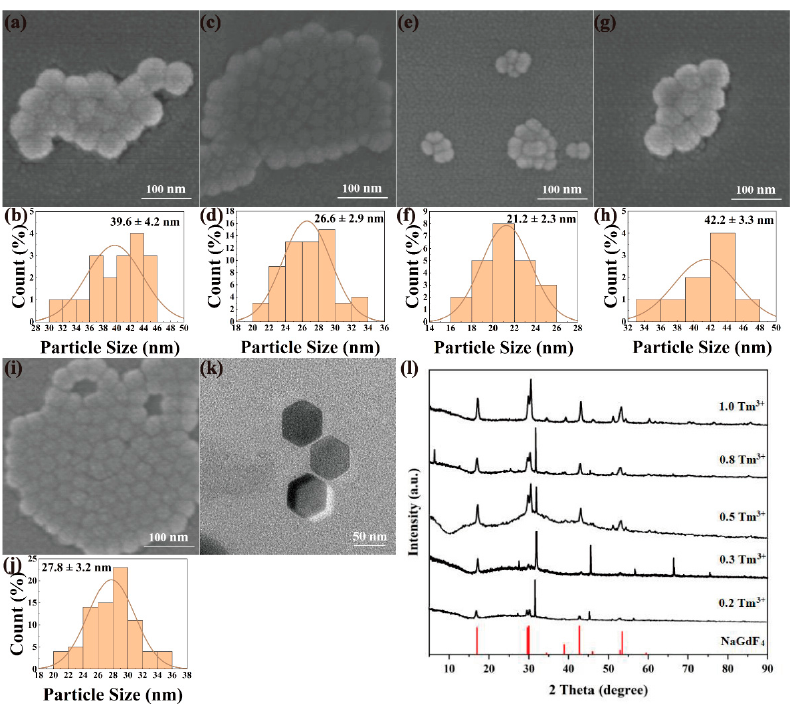
Figure 6. SEM, particle size analysis, TEM, and XRD images of NaGdF 4 : 20%Yb 3+ , x%Tm 3+ . ( a ) x = 0.2, ( c ) x = 0.3, ( e ) x = 0.5, ( g ) x = 0.8, ( i ) x = 1.0; particle size analysis: ( b ) x = 0.2, ( d ) x = 0.3, ( f ) x = 0.5, ( h ) x = 0.8, ( j ) x = 1.0; ( k ) TEM image of NaGdF 4 : 20%Yb 3+ , 0.5%Tm 3+ ; ( l ) NaGdF 4 : 20%Yb 3+ , x%Tm 3+ (X = 0.2, 0.3, 0.5, 0.8, 1.0).